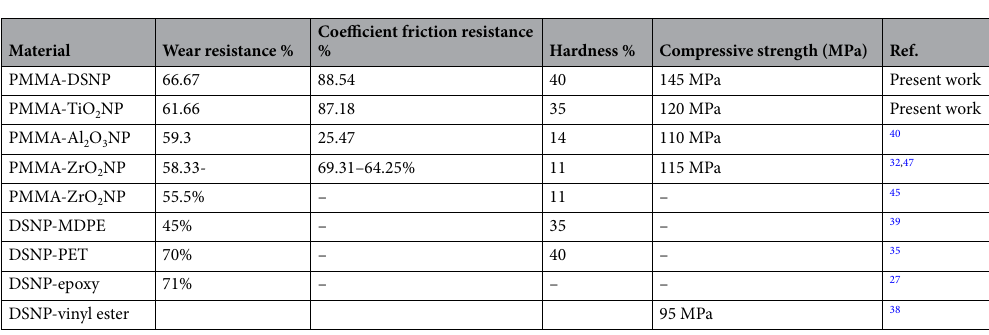
Table 4. Comparison of the mechanical properties of the PMMA-DSNP and PMMA-TiO 2 NP nanocomposites with those of other nanofiller-based composites.